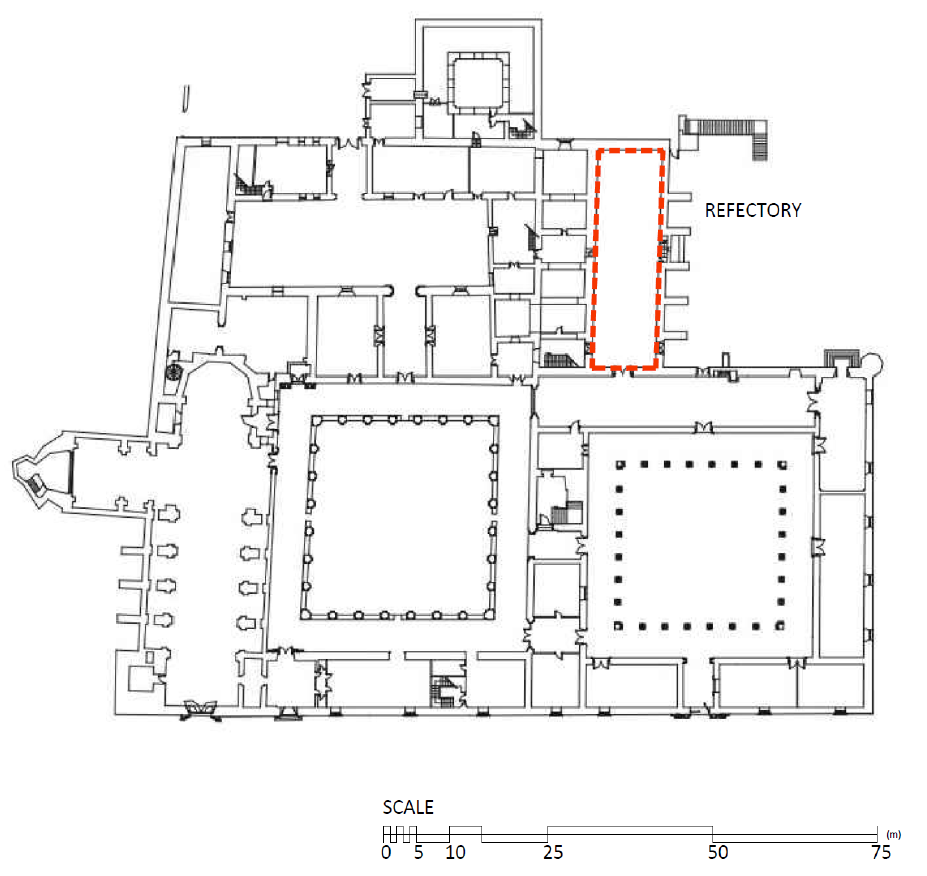
Figure 1. Floor plan of Santo Domingo de